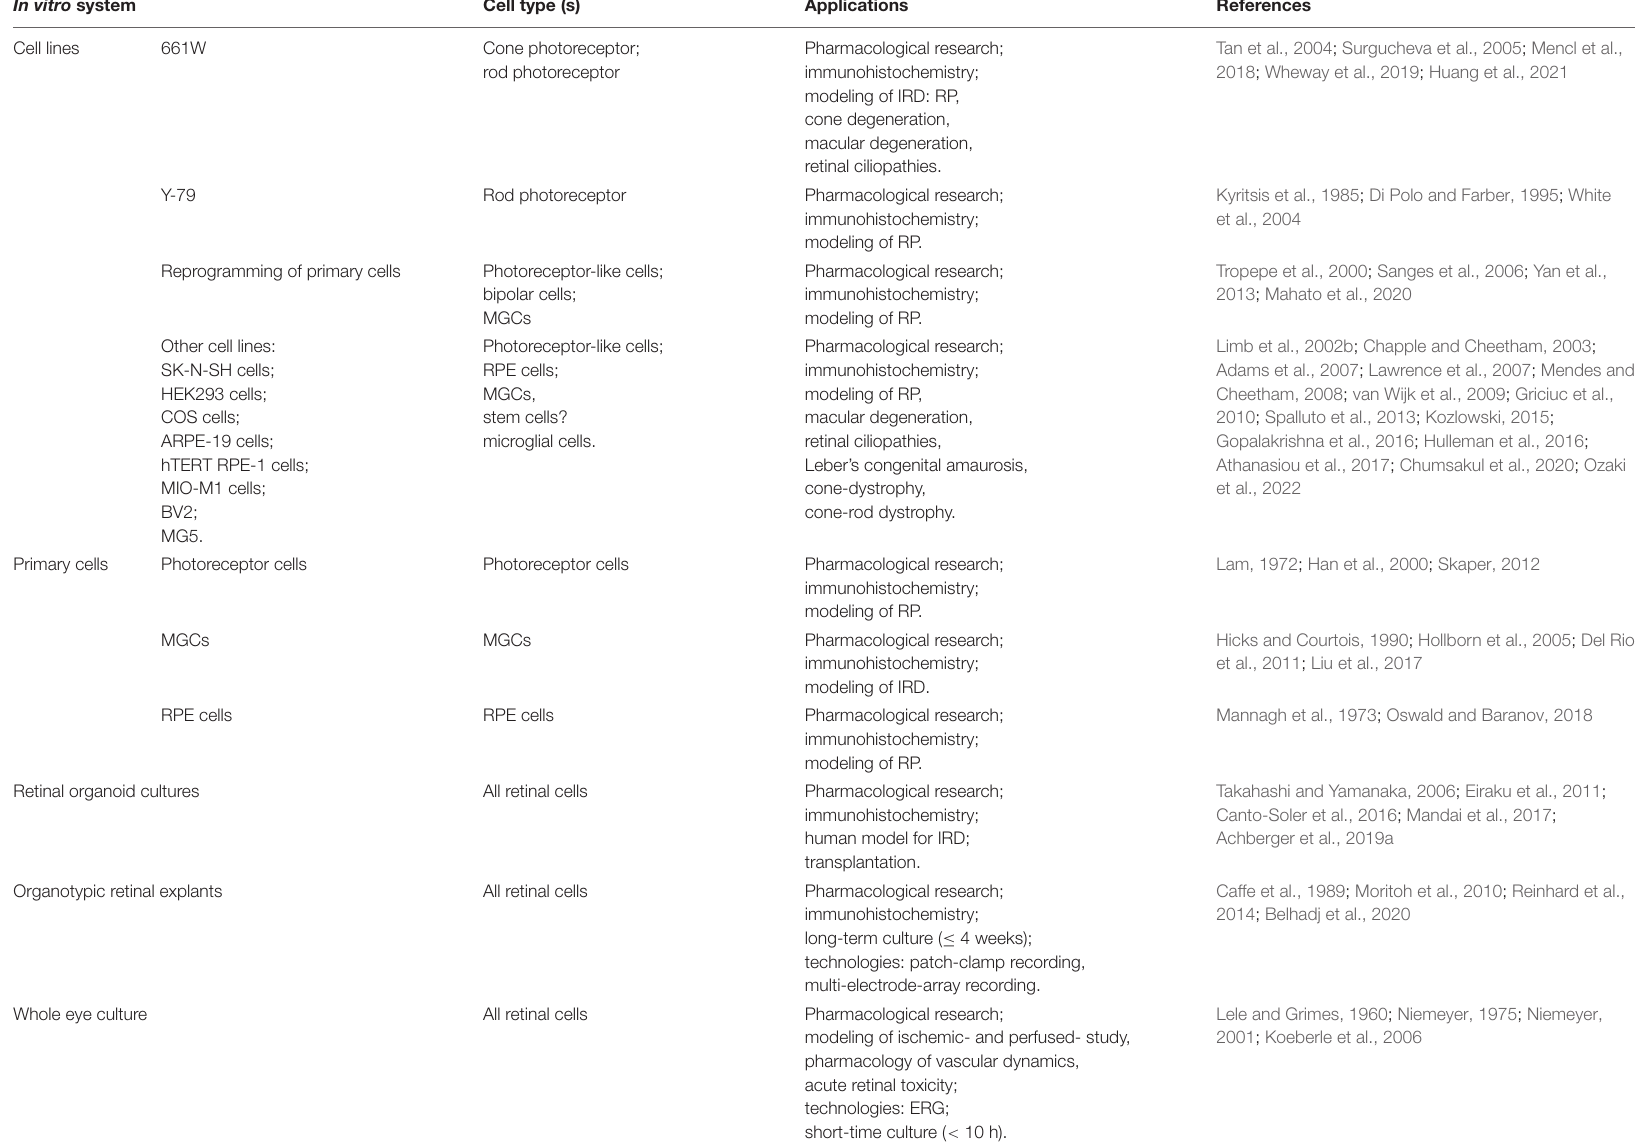
TABLE 1 | Overview of in vitro test systems available for retinal neuroprotection research. In vitro